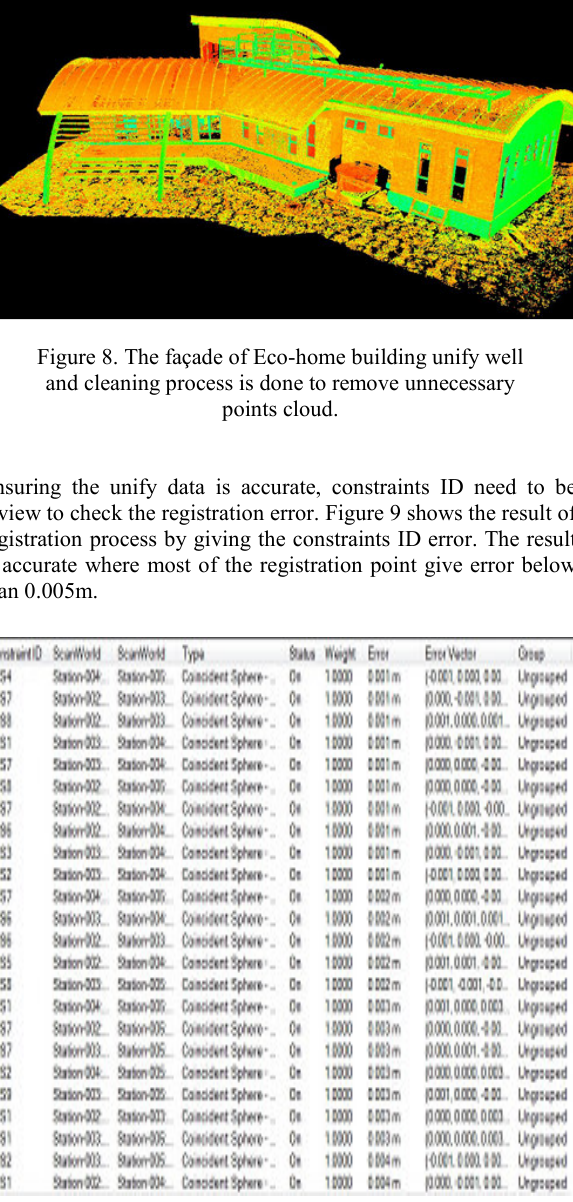
Figure 9. Accuracy of registration process. The result shows the accuracy can achieve below than 0.005m.